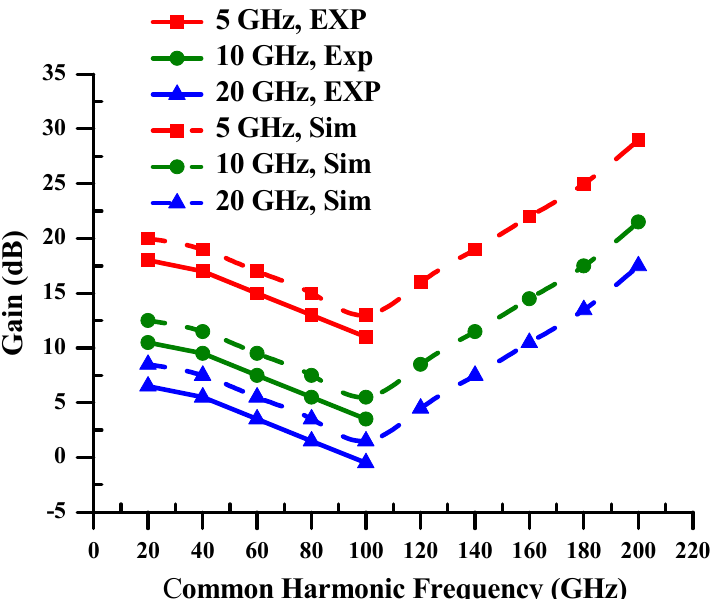
Figure 8. The experimental and simulated conversion gains for the outbound “AND” signal.